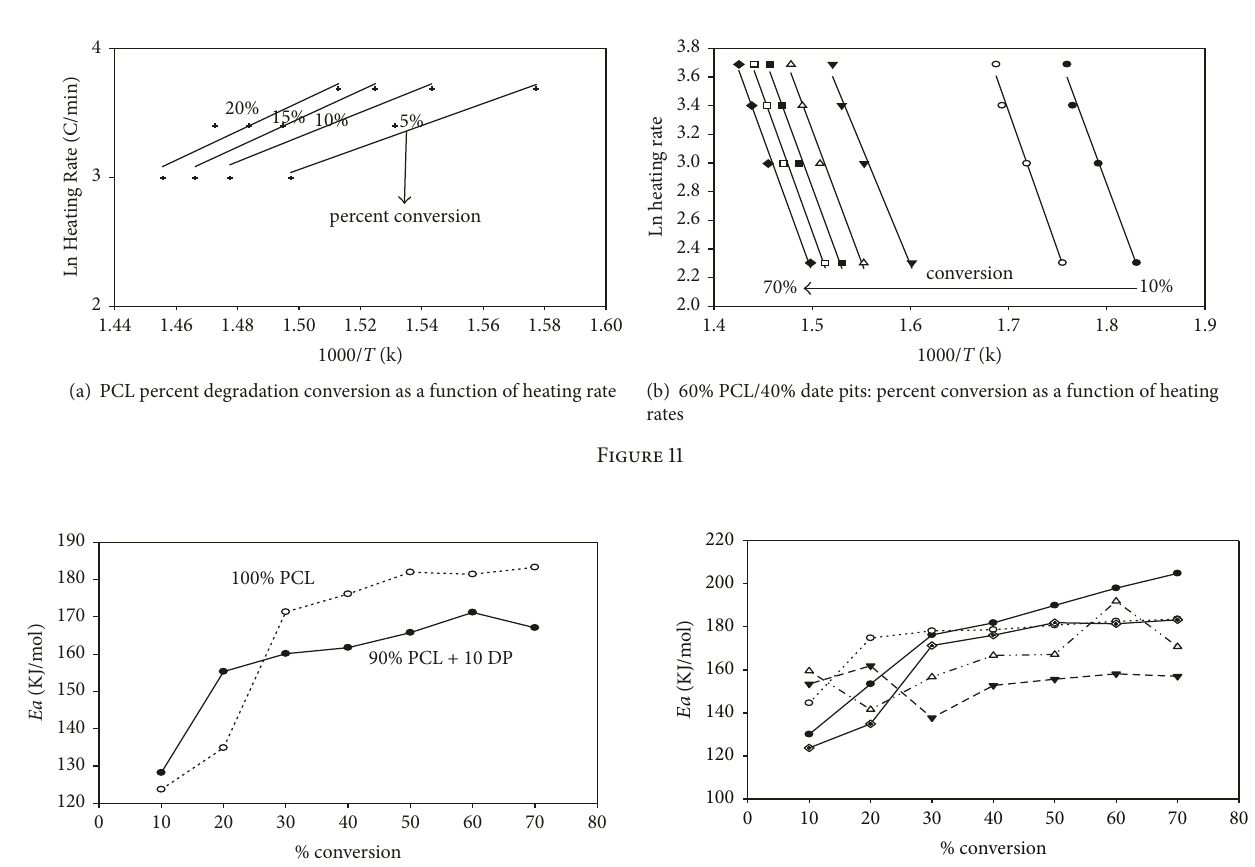
Figure 12: Activation energy as a function of percent conversion of 100% PCL and 90% PCL + 10% date pits (DP).